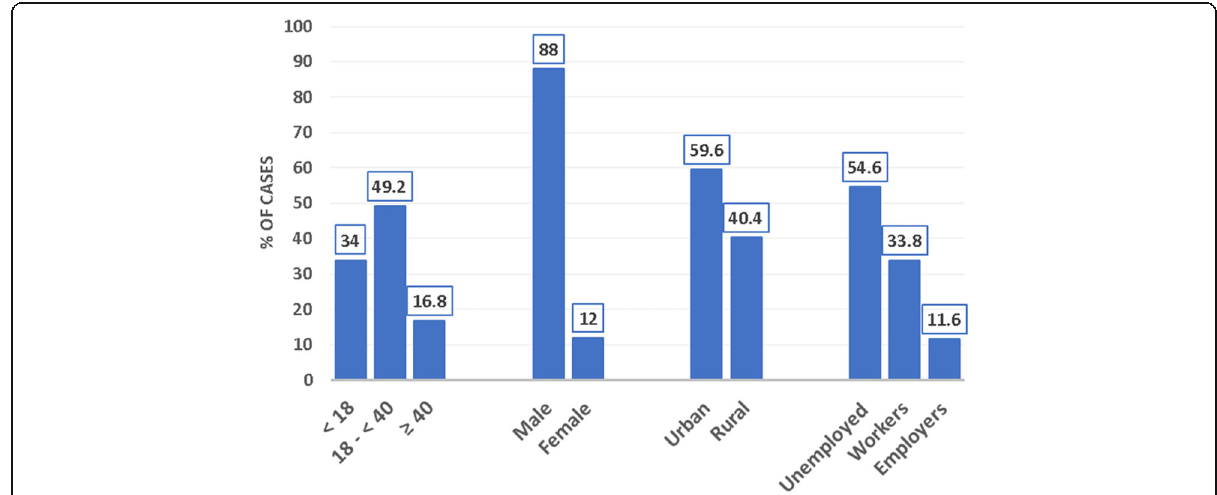
Fig. 1 Socio-demographic characteristics of combined craniomaxillofacial fracture cases in the studied period (2011 –